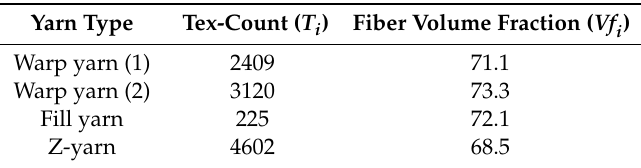
Table 2. Fiber volume fraction of yarns.